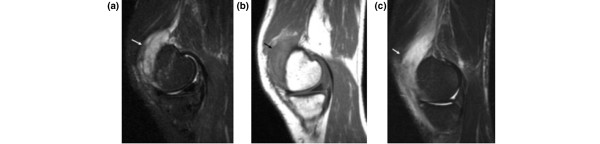
Late magnetic resonance imaging (MRI) findings of heterotopic ossification (HO). HO in the left knee of a 32-year-old male patient hospitalised in the intensive care unit for traumatic brain injury. MRI performed 4 weeks after clinical suspicion of HO. (a) Sagittal fast spin-echo short inversion-recovery MR image (3,000/80; inversion time, 165 milliseconds) shows heterogeneous high signal of the innermost part of the vastus medialis muscle (arrow). (b) Sagittal T1-weighted spin-echo MR image (650/17) shows heterogeneous high signal of the innermost part of the vastus medialis muscle (arrow). (c) Sagittal contrast-enhanced fat-suppressed T1-weighted spin-echo MR image (650/17) shows heterogeneous enhancement of the innermost part of the vastus medialis muscle (arrow).